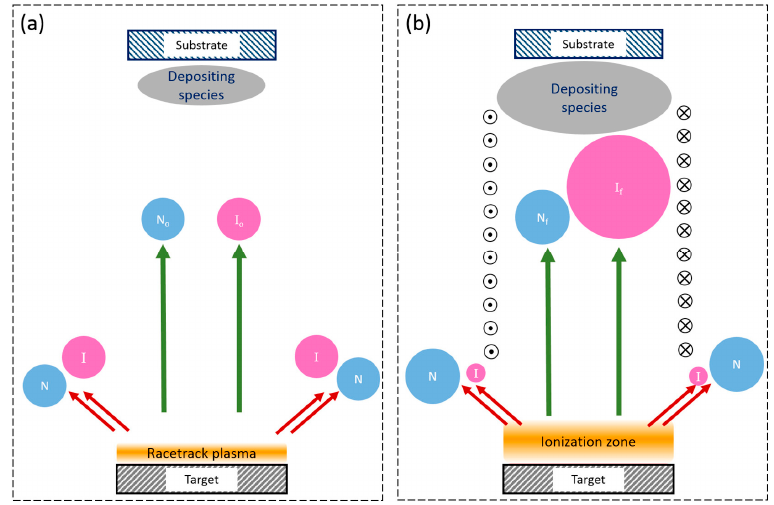
Figure 10. Schematic illustration of a film deposition, ( a ) without the external device and ( b ) with the application of an external magnetic field. Reproduced from [100] with permission. Copyright 2019 Elsevier.